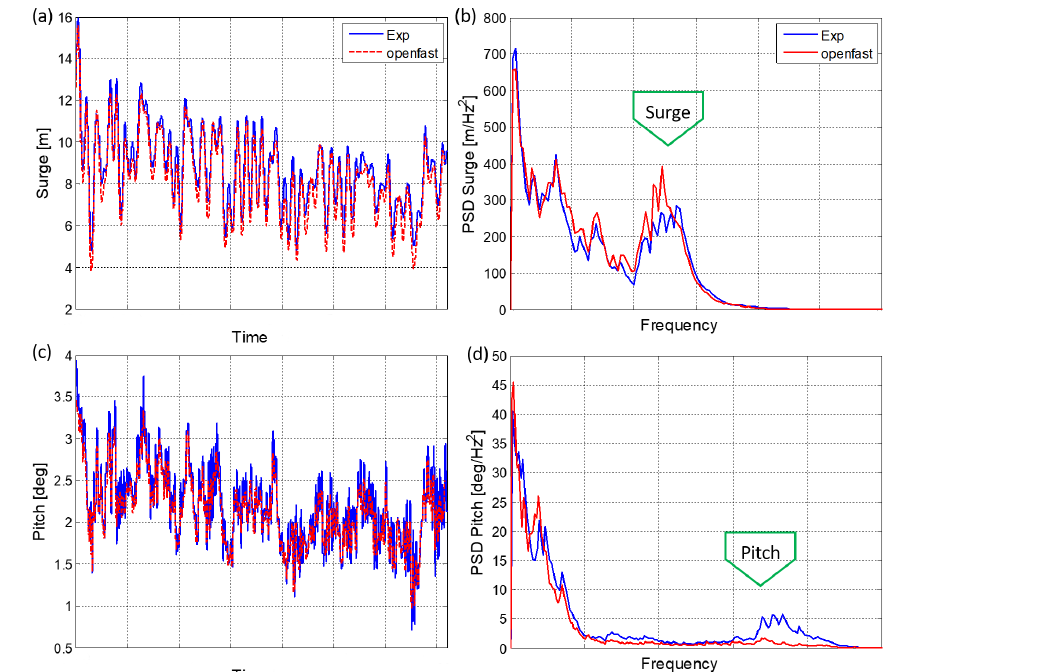
Figure 7. Platform response comparison between experiments and OpenFAST simulation for surge and pitch under 7.5ms − 1 turbulent mean wind speed without waves. (a) Surge response in time domain, (b) surge response PSD, (c) pitch response in time domain and (d) pitch response PSD.